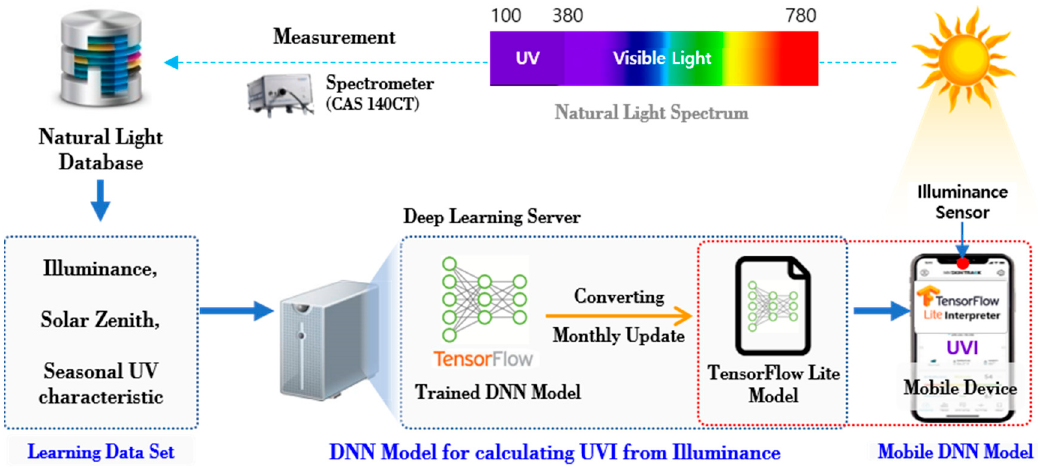
Figure 1. Overview of the mobile deep learning system.